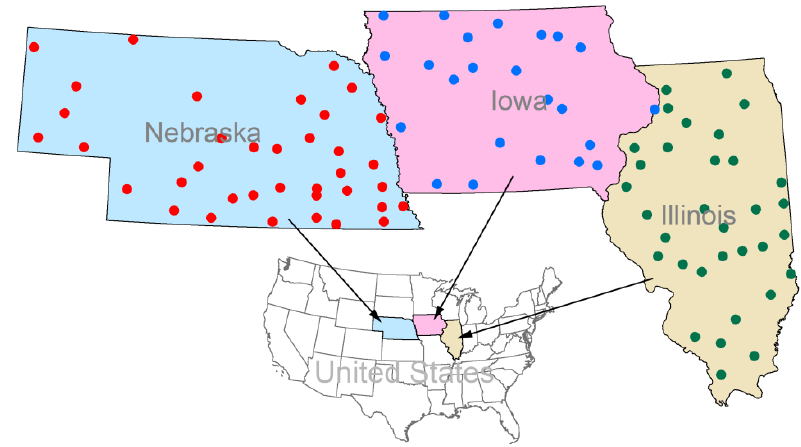
Figure 1. Illustration of study area and selected meteorological stations. The study area covers three states of the United States: Iowa, Illinois and Nebraska. Stations are marked as circle dots, and colors are labeled for different states. The number of meteorological stations of Iowa (blue dots), Illinois (green dots), and Nebraska (red dots) is 23, 33, and 37,